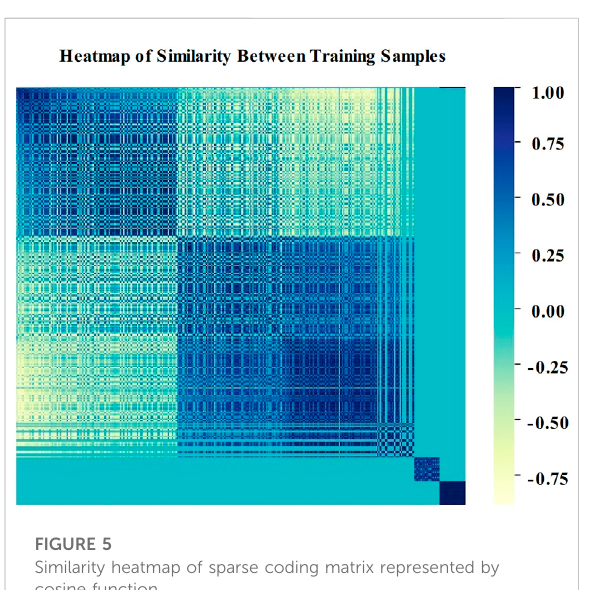
FIGURE 5 Similarity heatmap of sparse coding matrix represented by cosine function.